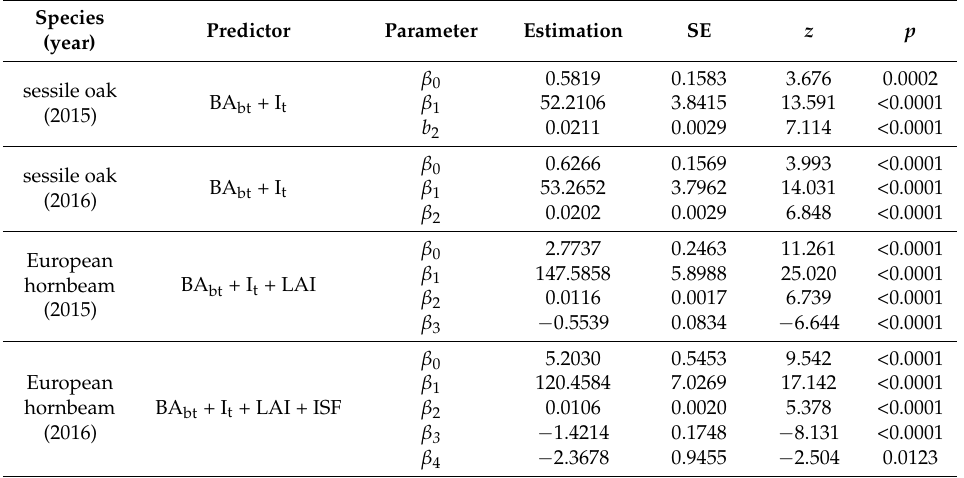
Table 4. The estimation of parameters for the number of best live new sprouts models.